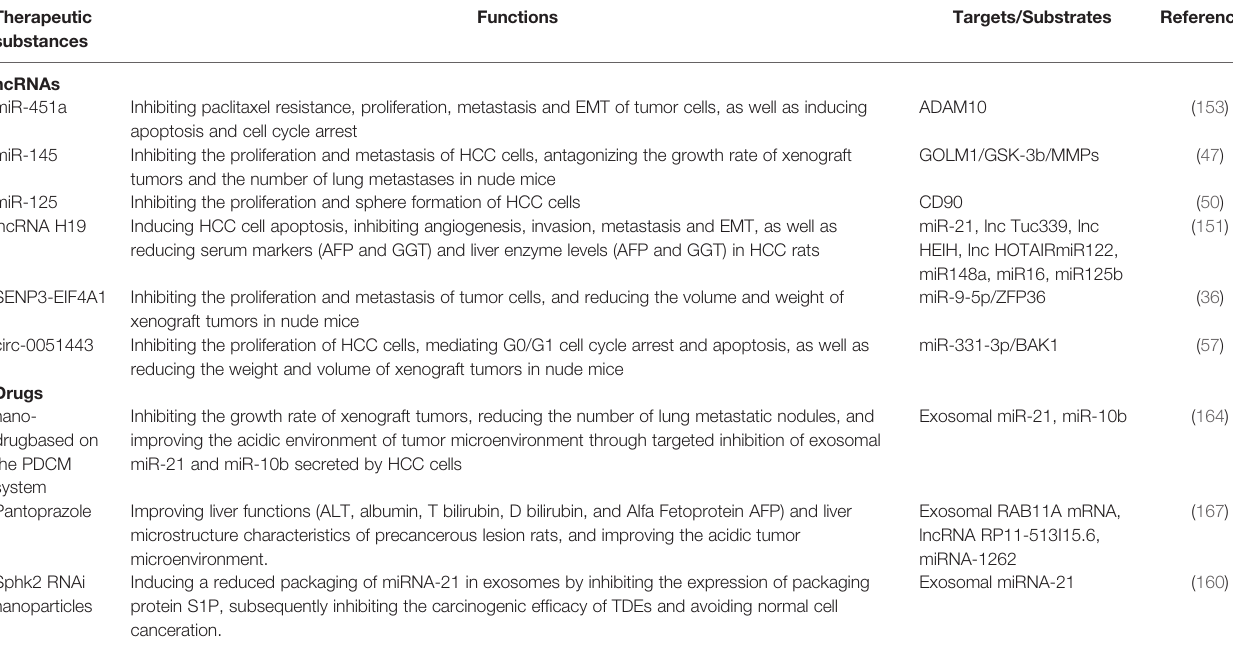
TABLE 2 | Therapeutic target of exosomal ncRNAs for